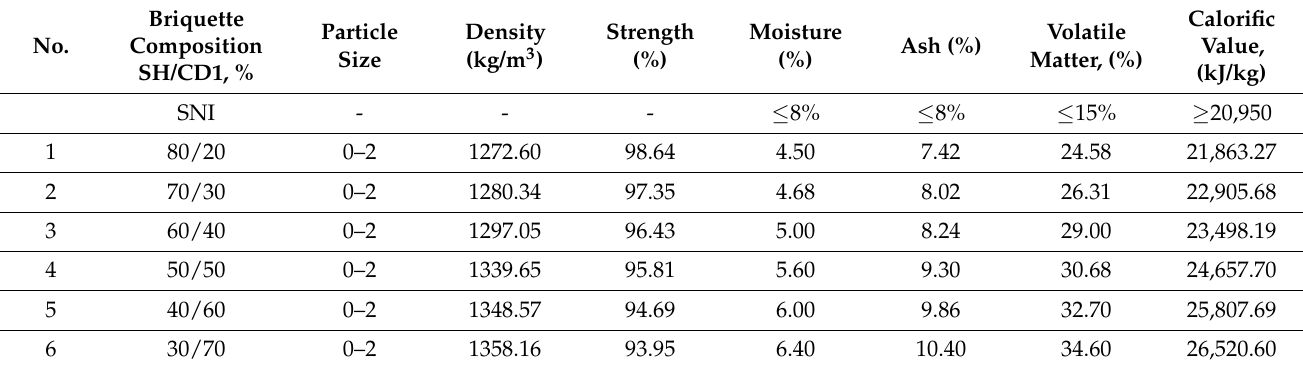
Table 10. The results of the analysis of briquettes (leaves and Shubarkul coal dust).